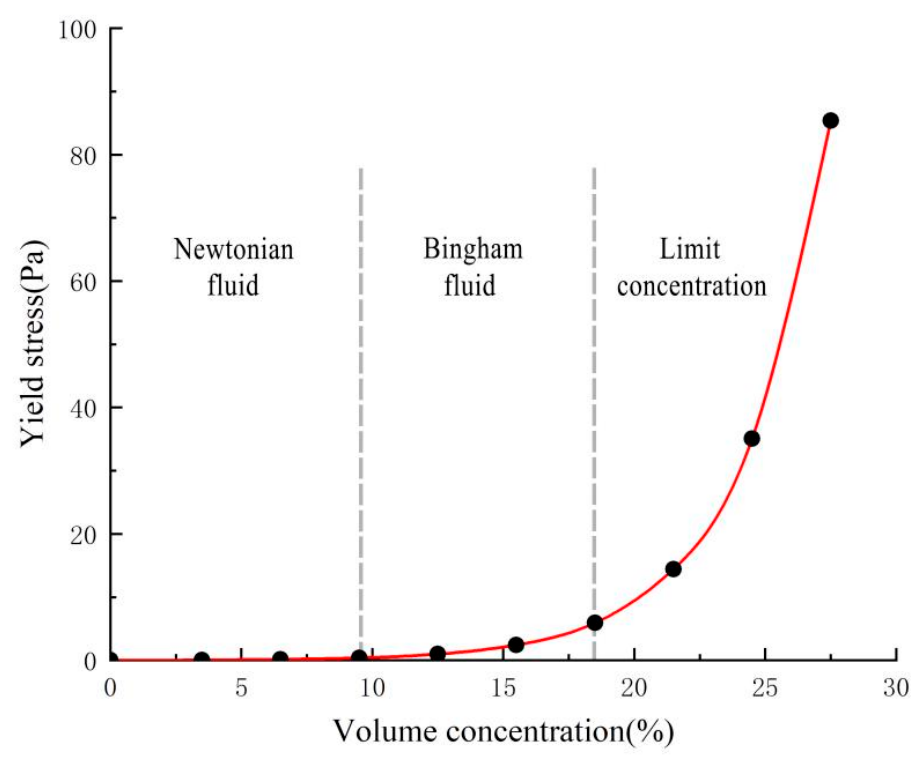
Figure 8. The yield stress versus volume concentration curve of the deep-sea sediment, showing the transition from Newtonian fluid to non-Newtonian fluid and limiting concentration.